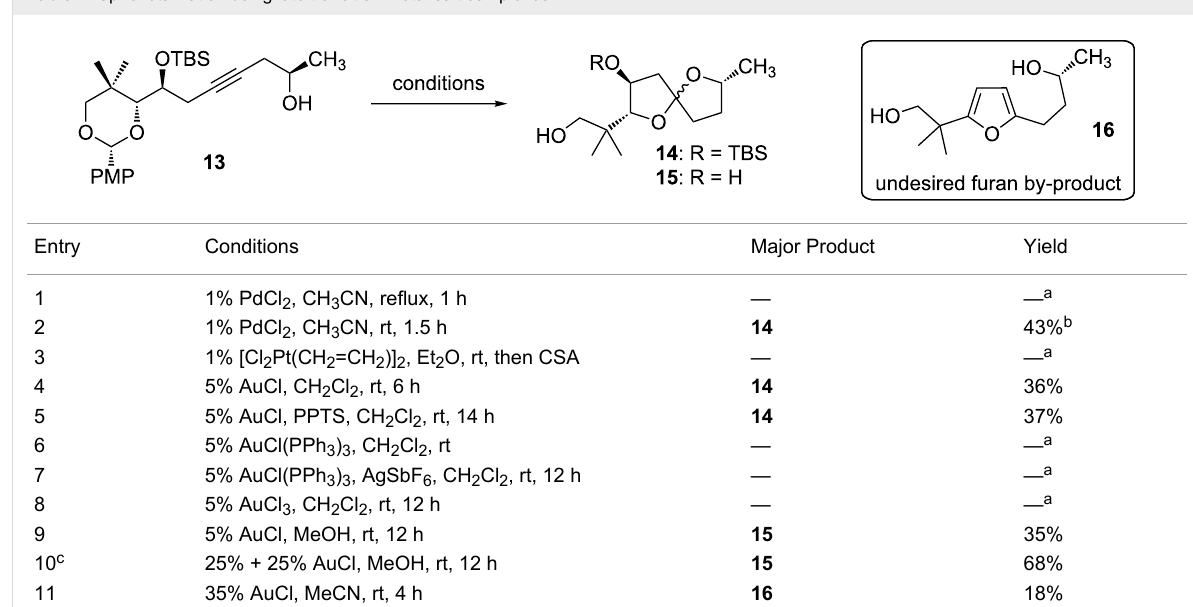
Table 1: Spiroketalization using late transition metal salt